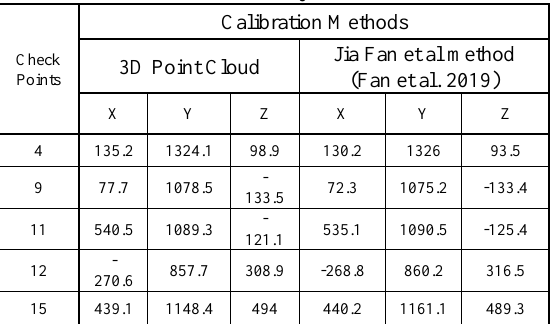
Table 3. Coordinates of check points in two different